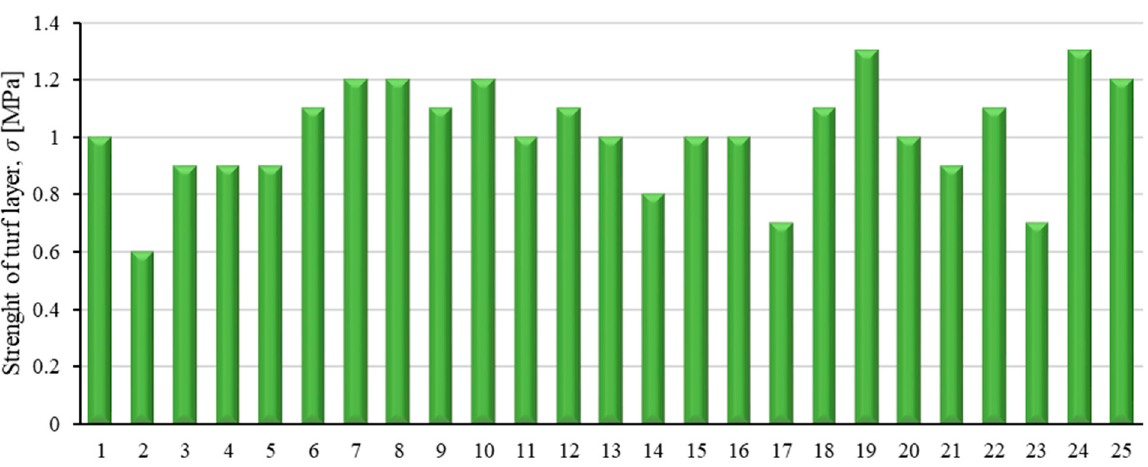
Figure 17. Results of the strength of the turf layer of the airfield pavement on the runway end safety areas. Table 8. Average values of the strength of the AFE’s turf layer. AFE